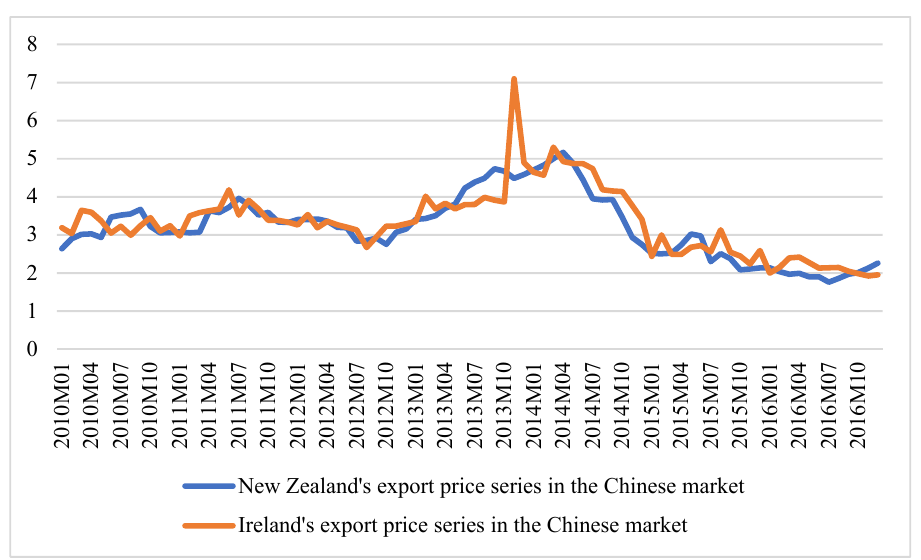
Figure 3. Monthly SMP export prices for Ireland and New Zealand to Chinese market between January 2010 and December 2016.